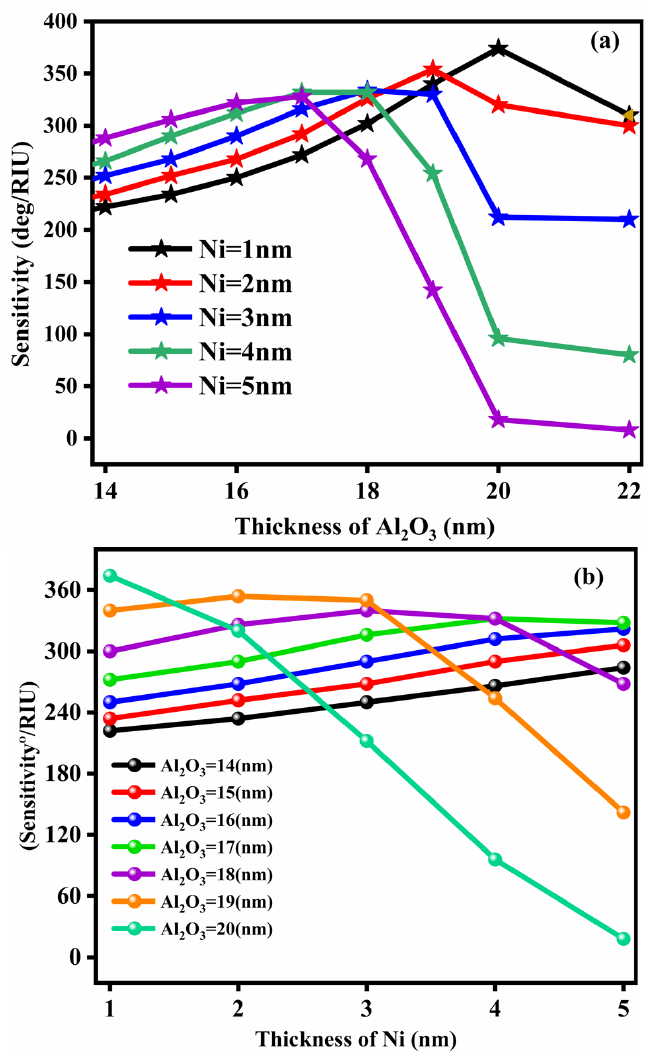
Figure 8. ( a ) Variation of sensitivity vs. Al 2 O 3 (nm). ( b ) Variation of sensitivity vs. Ni